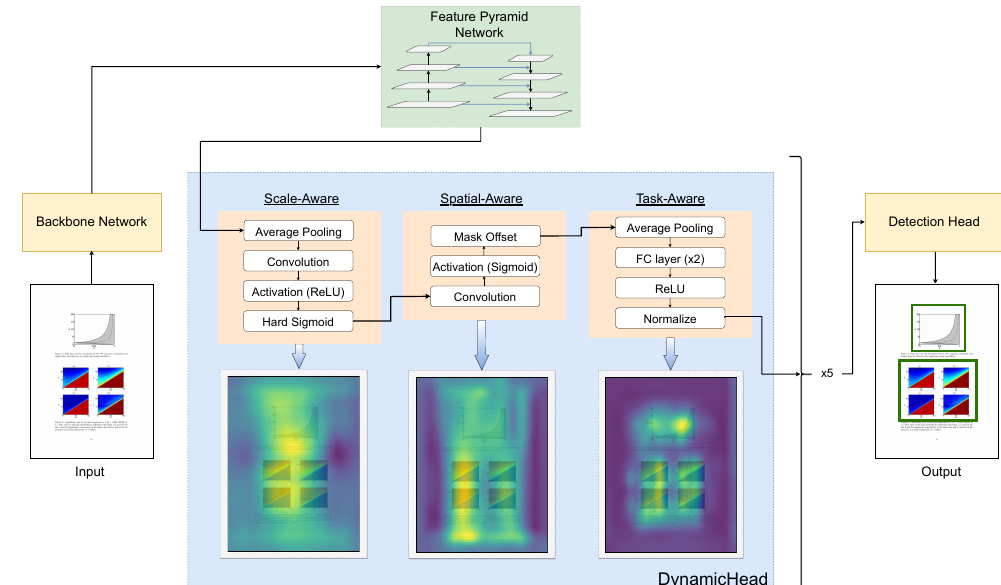
Figure 2. System design: the pipeline for page object detection using attention-mechanism. It consists of one of the backbones (i.e., ResNet-50, ConvNeXt, or Swin Transformer) which acts as the bottom-up feature extractor for the Feature Proposal Network (FPN). The top-down pathway of FPN performs deconvolution in four blocks, each block with varying scale. Then, the multi-scale features from different blocks of FPN are fed into the attention module, DynamicHead. The DynamicHead module sequentially processes the fed features through scale-aware, spatial-aware, and task-aware sub- modules. To obtain optimal attention, the DynamicHead module is applied to the features multiple times (i.e., five times). The gradient maps extracted from each sub-module within DynamicHead are indicated by the blue arrows. Finally, the features are passed on to the detection head (e.g., Faster-RCNN or Sparse-RCNN) to obtain the bounding box